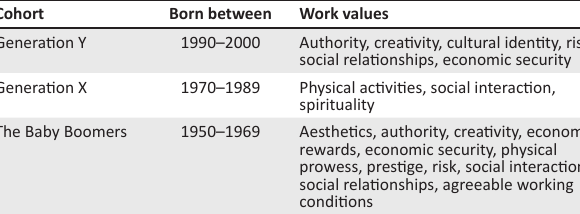
TABLE 5: Work values profiles of the different generational